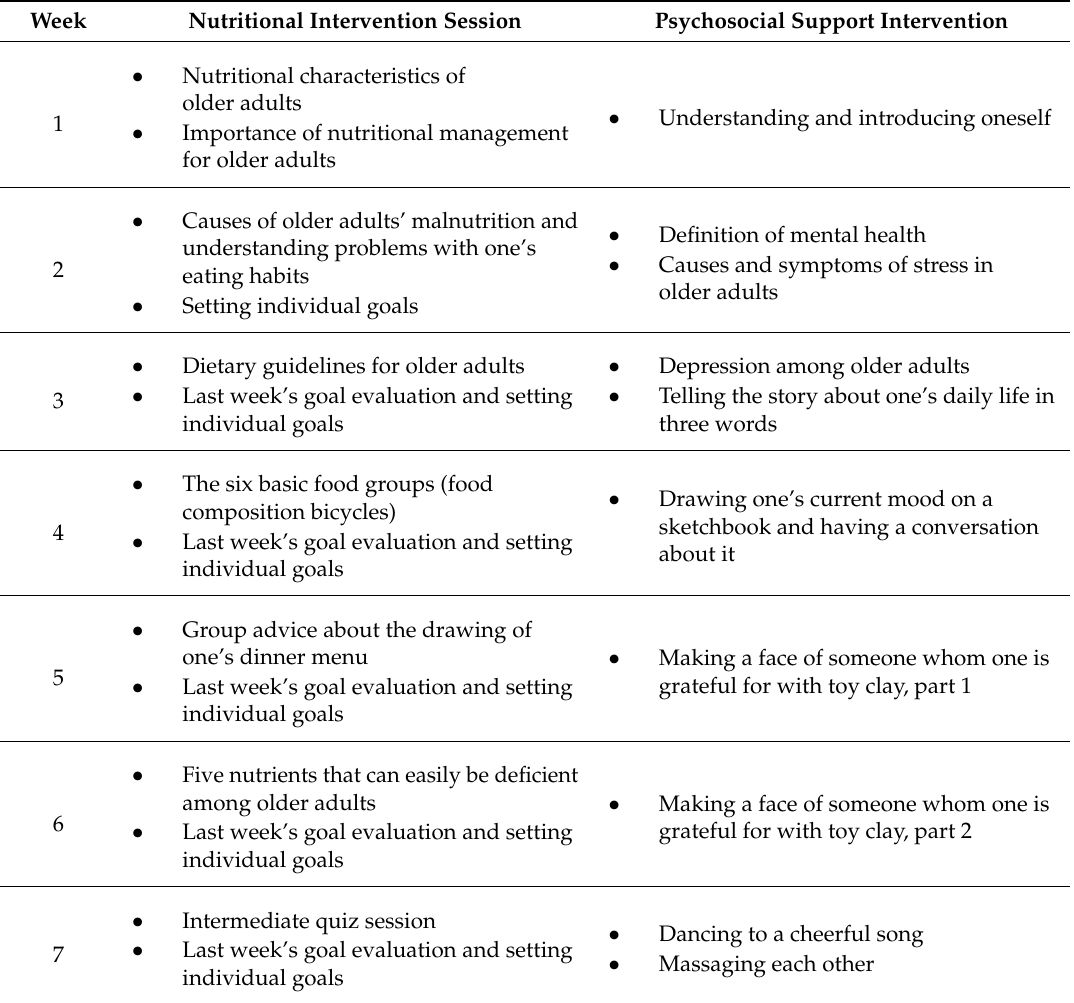
Table A1. Topics of the nutritional and psychosocial support intervention sessions in a person-centered nursing intervention for